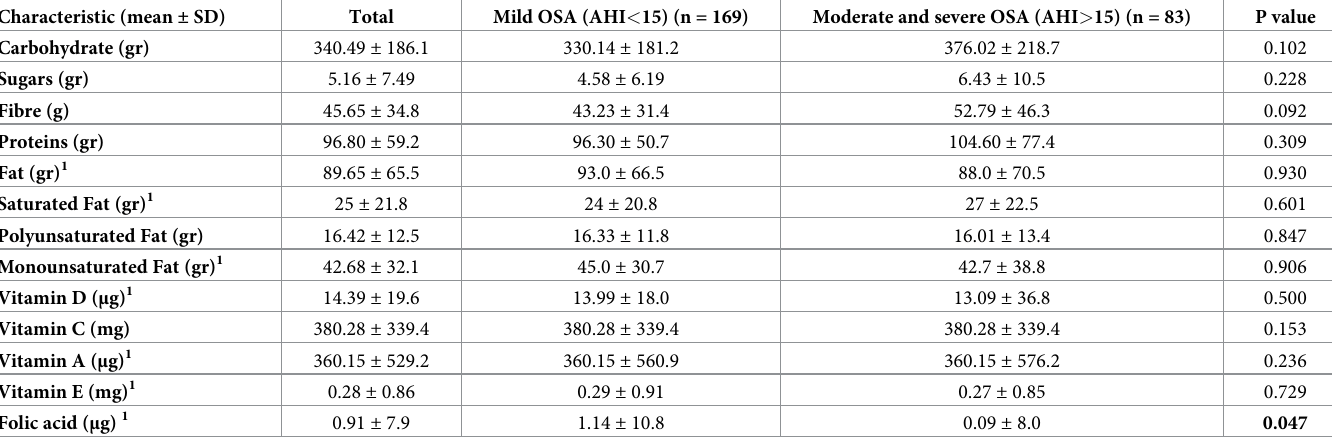
Table 2. Nutritional intake across categories of apnea hypopnea index representing obstructive sleep apnea (n = 303). Characteristic (mean ±